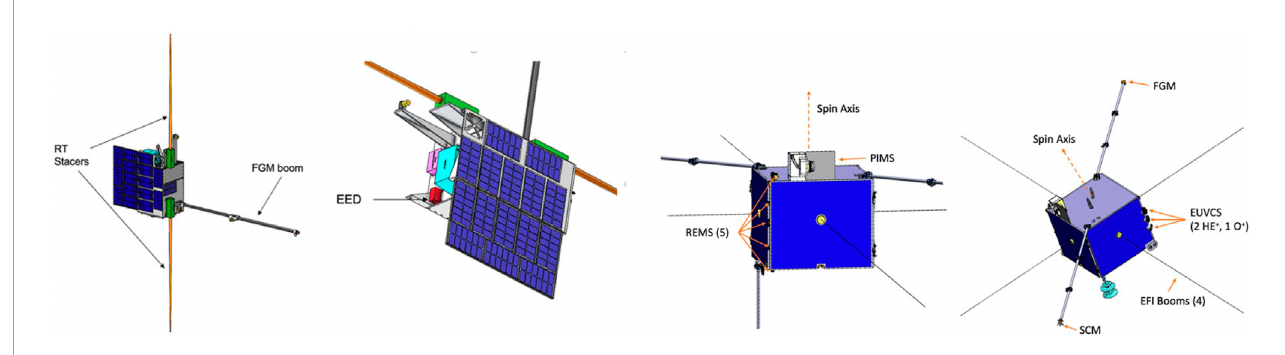
FIGURE 1 Rendering of the microsatellites equipped for radio tomography (left) and of the small satellites carrying plasma instrumentation (right). From Malaspina et